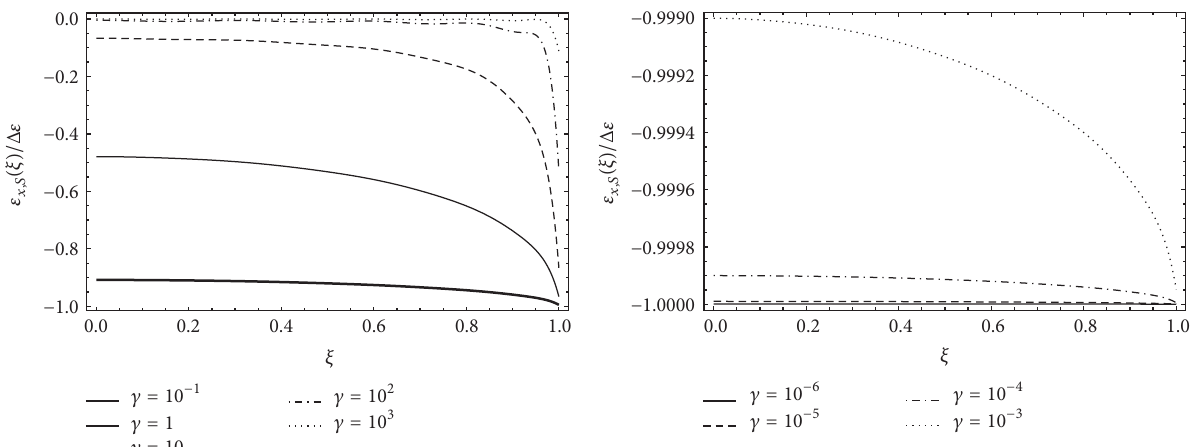
Figure 7: Longitudinal strain field for symmetric loading